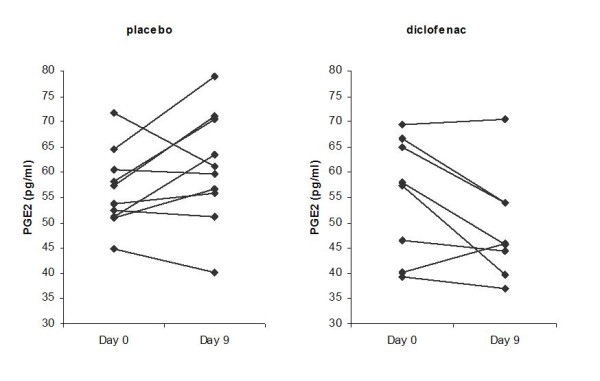
PGE2 levels before (day0) and after (day9) supplementation with placebo and diclofenac. The PGE2 response was significantly different for diclofenac compared to placebo (ANOVA, treatment * time interaction P < 0.05). In the diclofenac group, the difference in PGE2 level between day 9 and day 0 was significant (p-value = 0.0469).